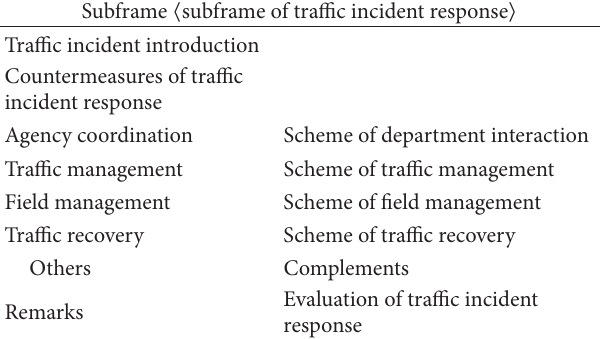
Table 2: Subframe of cases in